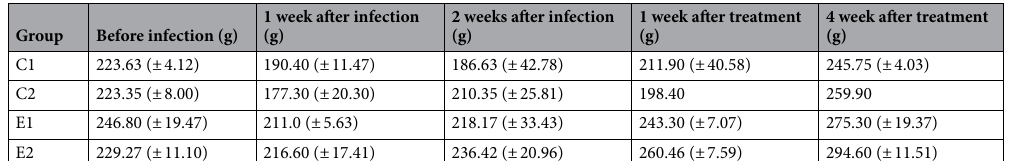
Table 2. Weight changes after infection with S. aureus and treatment in the control and experimental groups. The weight changes are depicted as mean ± standard deviation (SD).